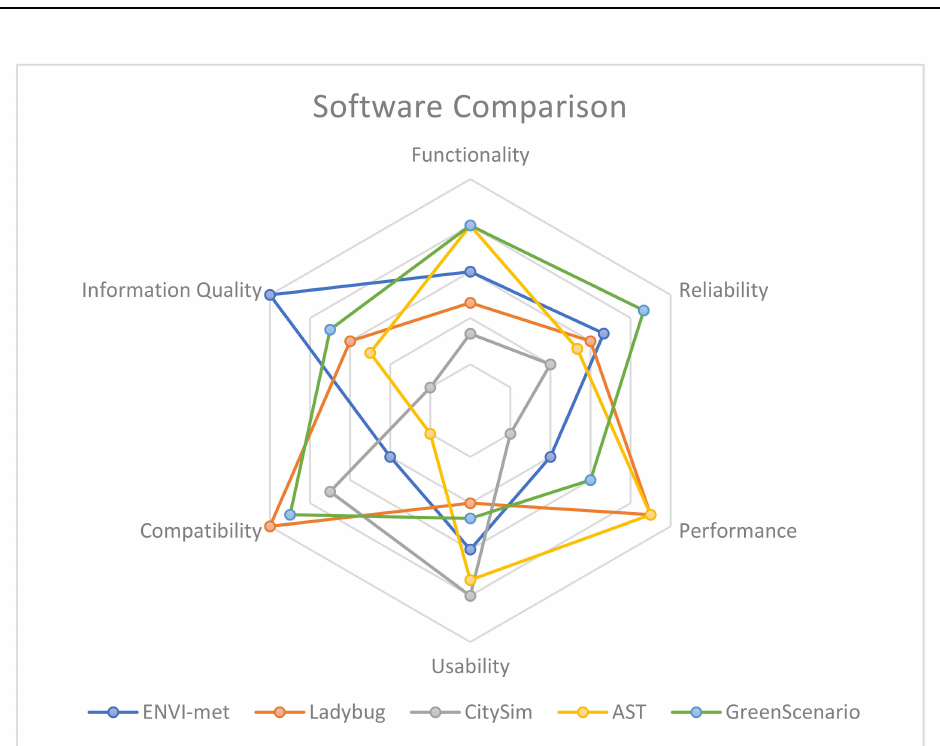
Figure 7. Comparison of software tools concerning different ISO 25010 aspects (source: